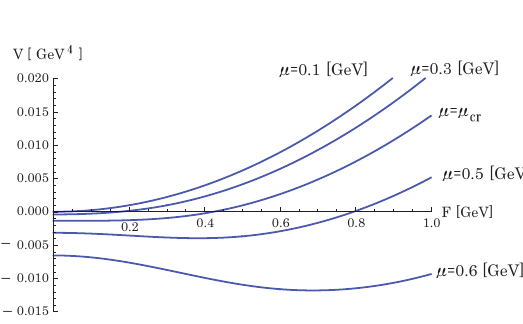
Figure 1. The e ff ective potential is shown as a function of F .